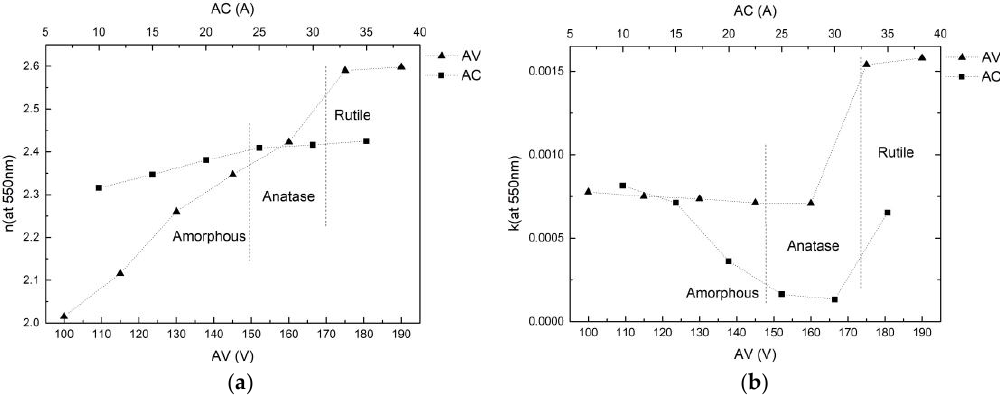
Figure 7. ( a ) n (550 nm) dispersion characteristics and ( b ) k (550 nm) dispersion characteristics. The AV represents the different accelerator voltage with constant current (15 A). The AC reflects the different accelerator current with the same voltage (145 V).